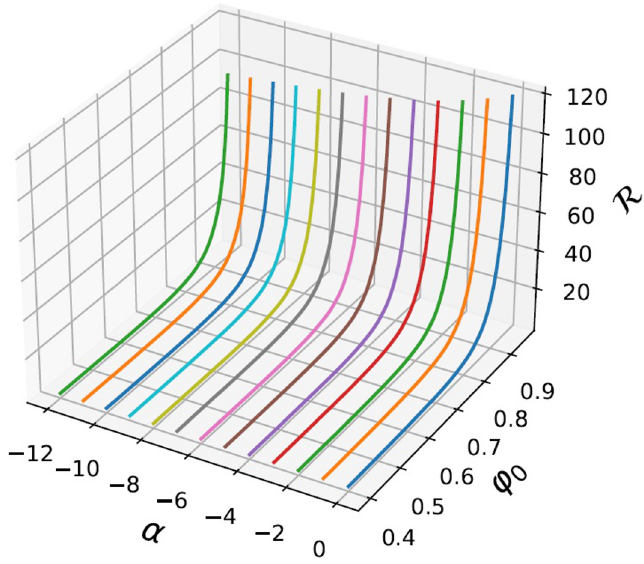
Figure 5 . The dimensionless curvature R as a function of the two parameters of the solution, ϕ 0 and α , for Nut end-point